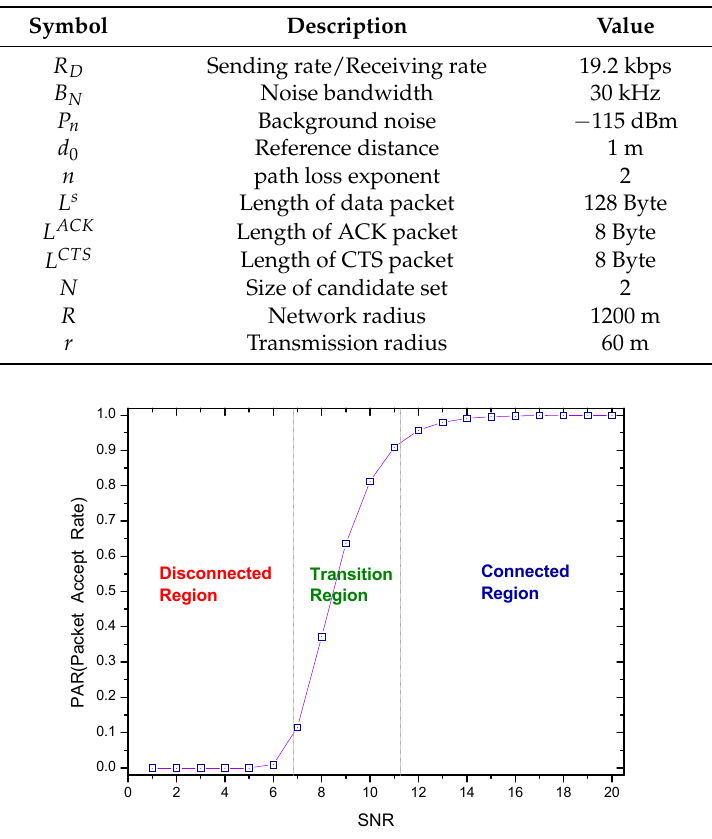
Table 1. Network parameters.